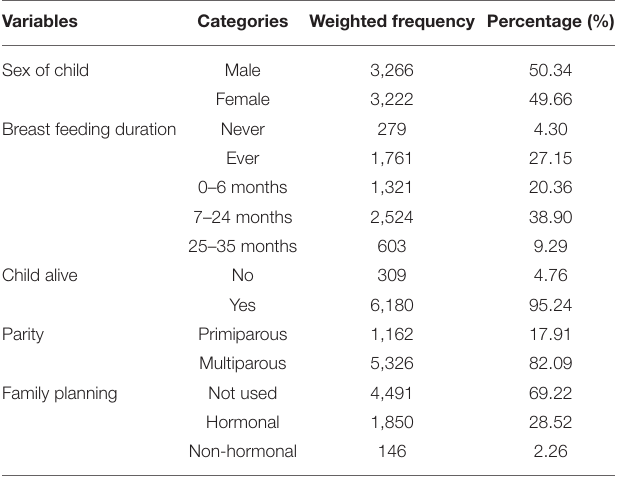
TABLE 2 | Obstetrical related characteristics of participants in Ethiopia, 2016 EDHS.